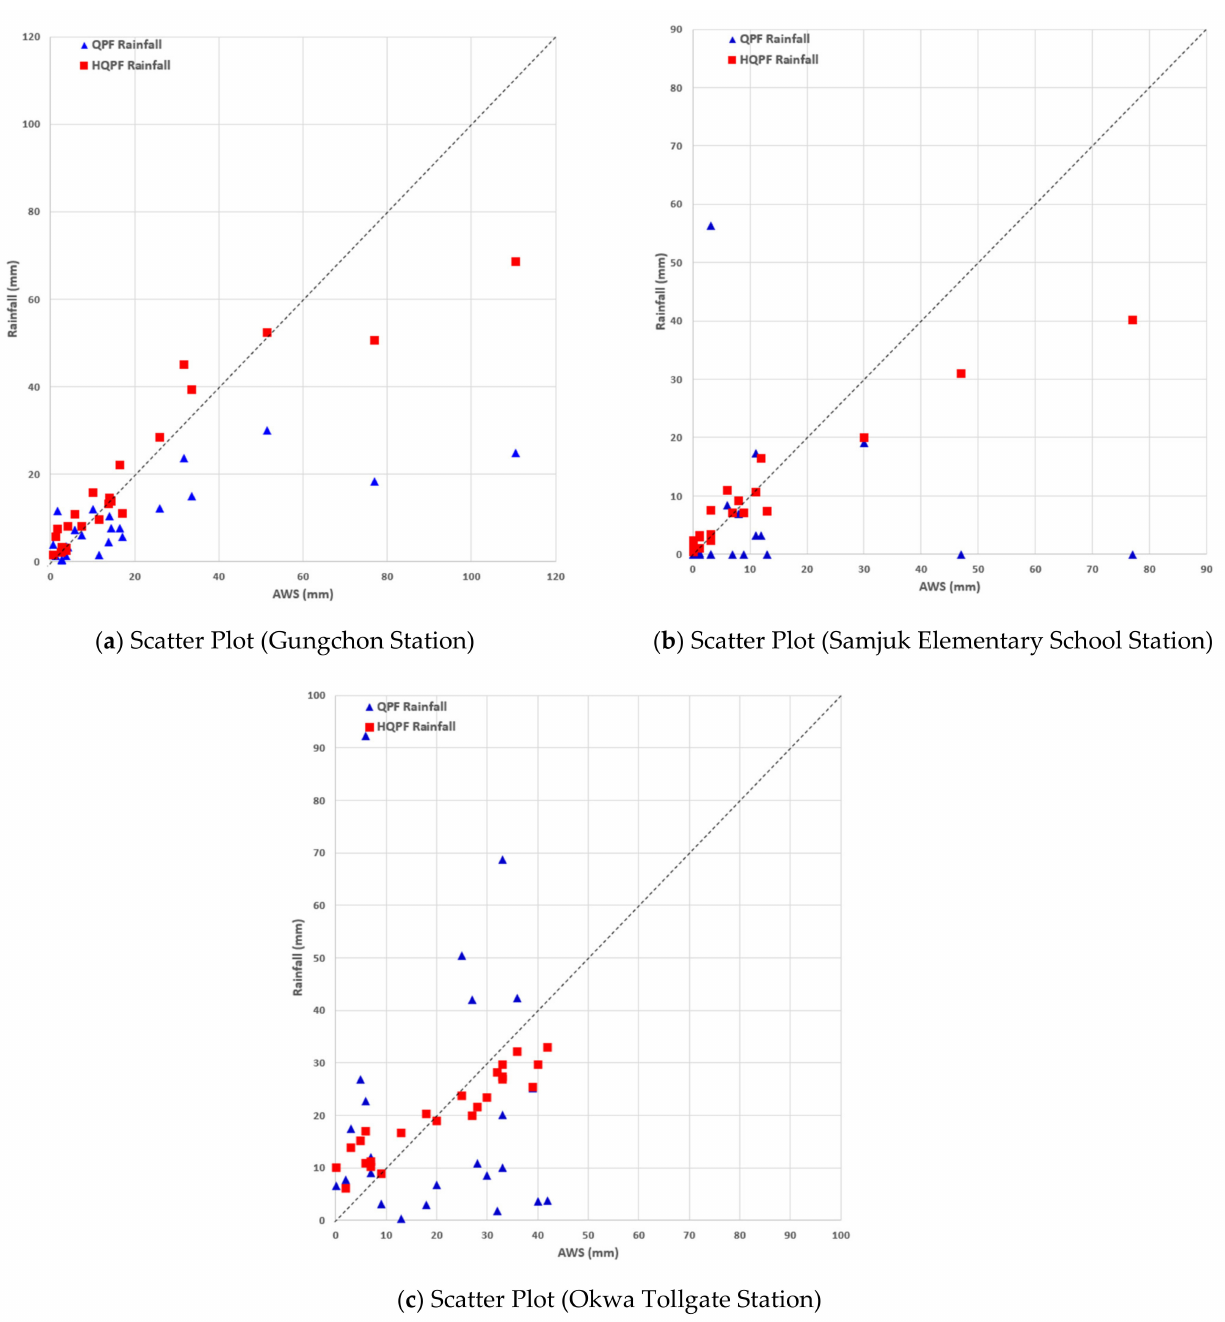
Figure 9. Scatter Plots of the Correlation between AWS-QPF and AWS-HQPF (Events I, II, and